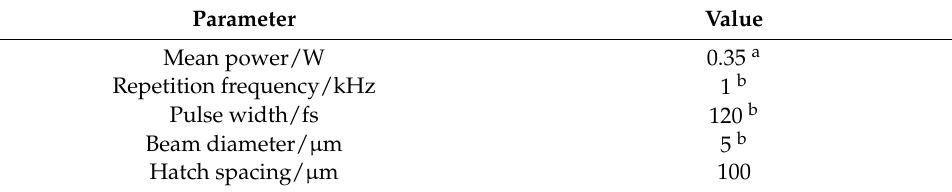
Table 4. Laser processing parameters.